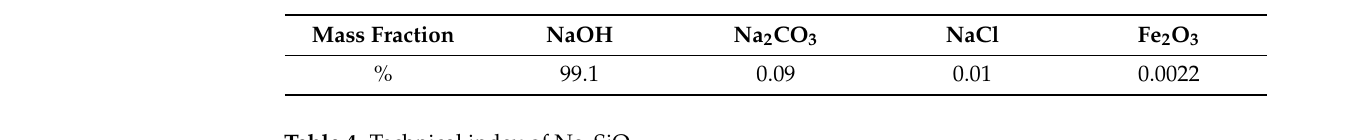
Table 4. Technical index of Na 2 SiO 3